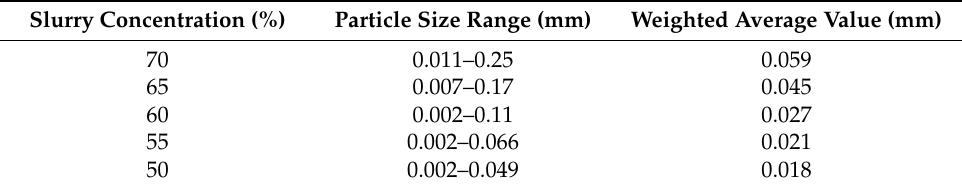
Table 2. Particle size distribution after